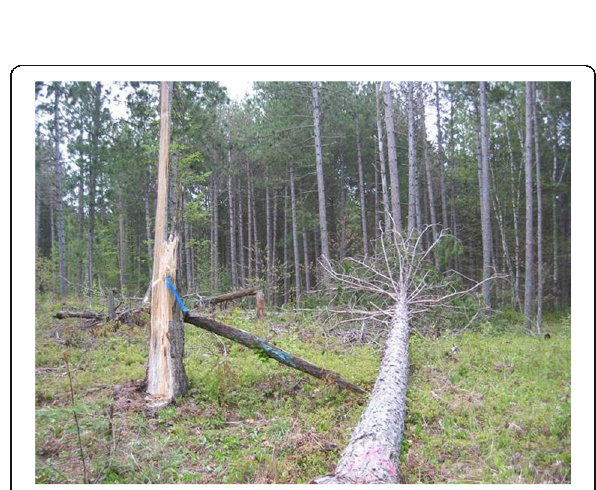
Fig. 7 This retained live red pine was snapped in a windstorm, increasing its ecological footprint in the stand; the resultant footprint should be buffered in future entries, so as to sustain the functioning of both the snag and downed